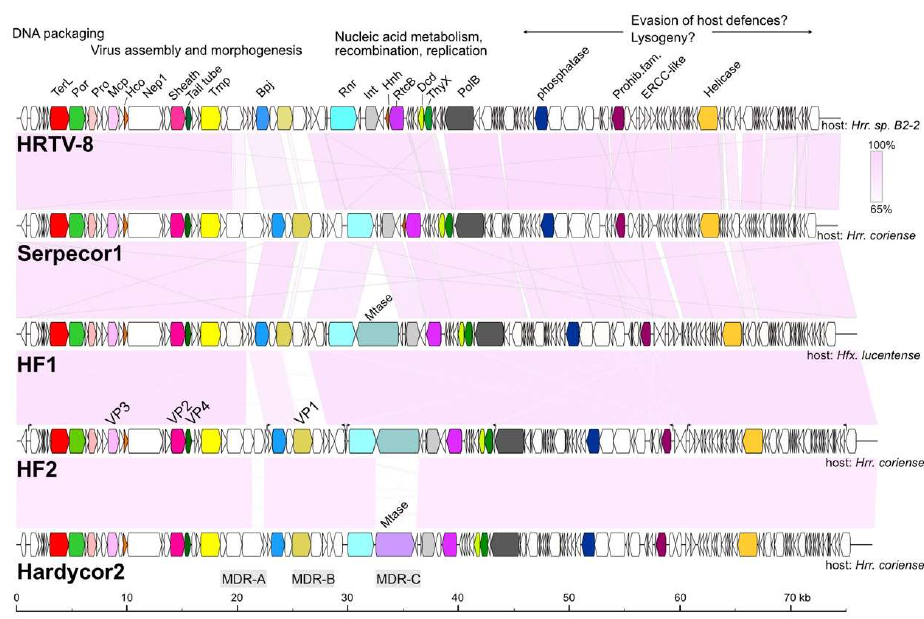
Figure 4. Genome maps of haloviruses Serpecor1 and Hardycor2 along with their closest relatives, HF1, HF2 and HRTV-8. Pink shading between the maps indicates nucleotide similarity values above 65% (scale at top right). Virus names are given at the left, host species are indicated at the right, and protein names are given at the top of HRTV-8, near the corresponding colored CDS. Corresponding genes on each map have the same color. Scale at bottom represents DNA length in kb. At top are headings indicating the known or likely functional modules (DNA packaging, Virus assembly, etc.). Major Divergent Regions (MDR) are indicated below the Hardycor2 map. Protein names are: TerL, large subunit terminase; Por, portal protein; Pro, prohead protease; Mcp, major capsid protein; Hco, head connector protein; Nep1, neck protein of type 1; Sheath, tail sheath protein; Tail tube, tail tube protein; Tmp, tape measure protein; Bpj, baseplate J family protein; Rnr, ribonucleotide reductase; Int, site-specific integrase; Hnh, HNH-endonuclease; RtcB, tRNA splicing ligase RtcB; Dcd,